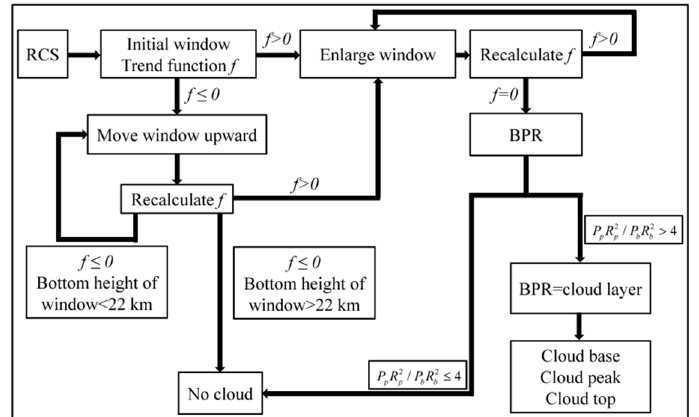
Figure 2. Schematic diagram of cloud discrimination algorithm.